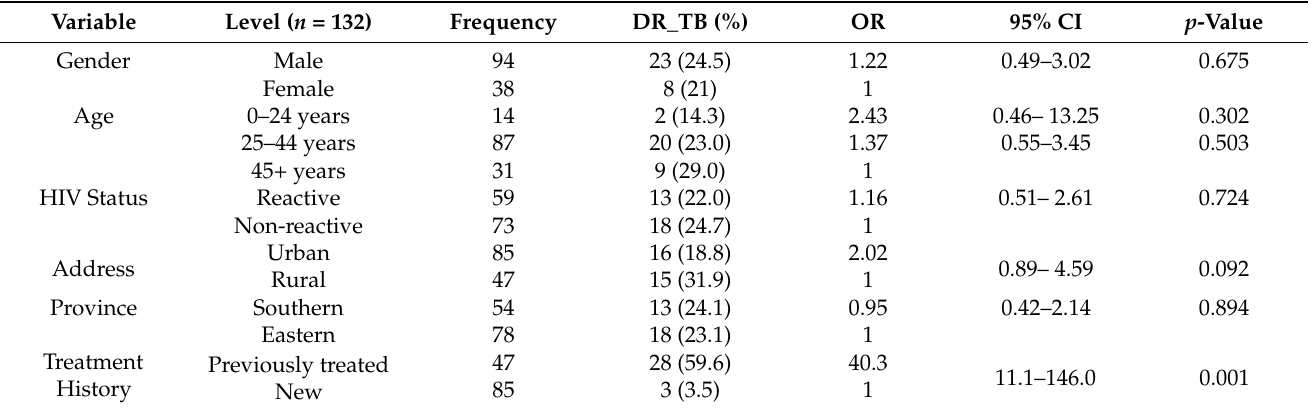
Table 6. Factors associated with drug-resistant